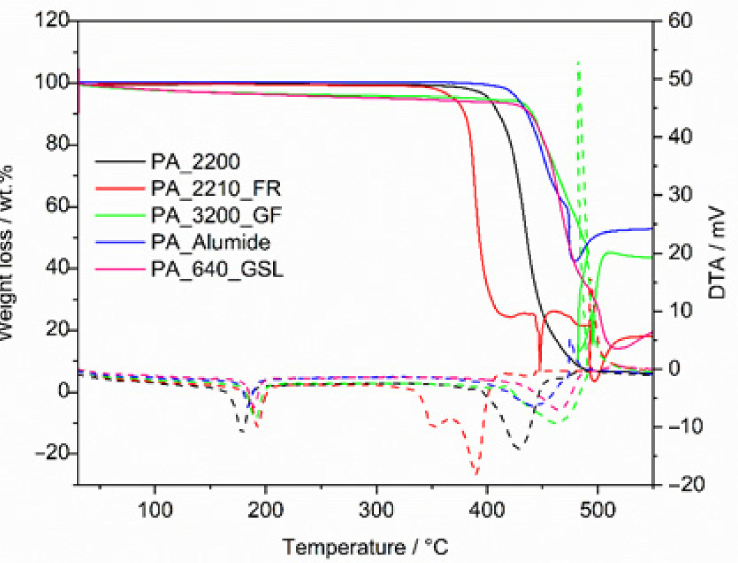
Figure 3. DTA-TGA graphs for all samples, where solid lines belong to weight loss, and dashed lines belong to DTA.